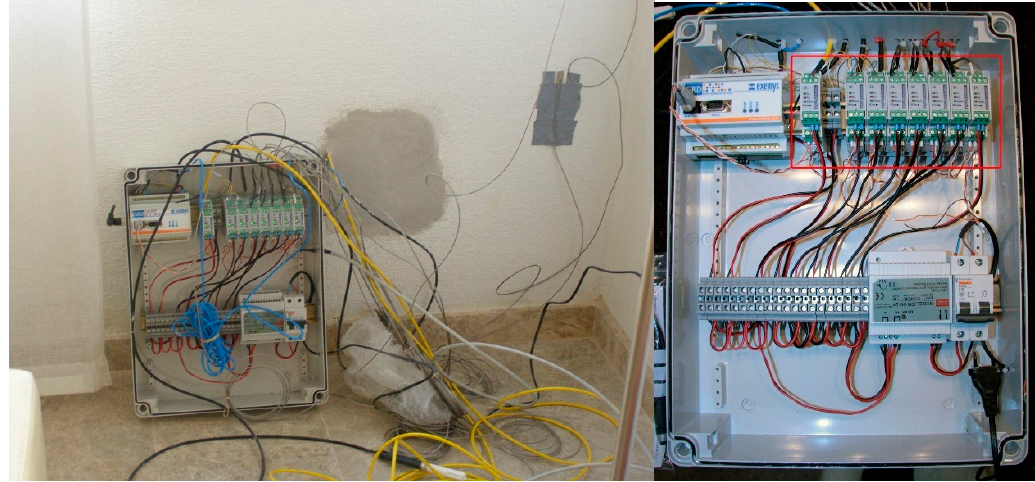
Figure 12. The data logger, data reception, and general packet radio service (GPRS) communication.